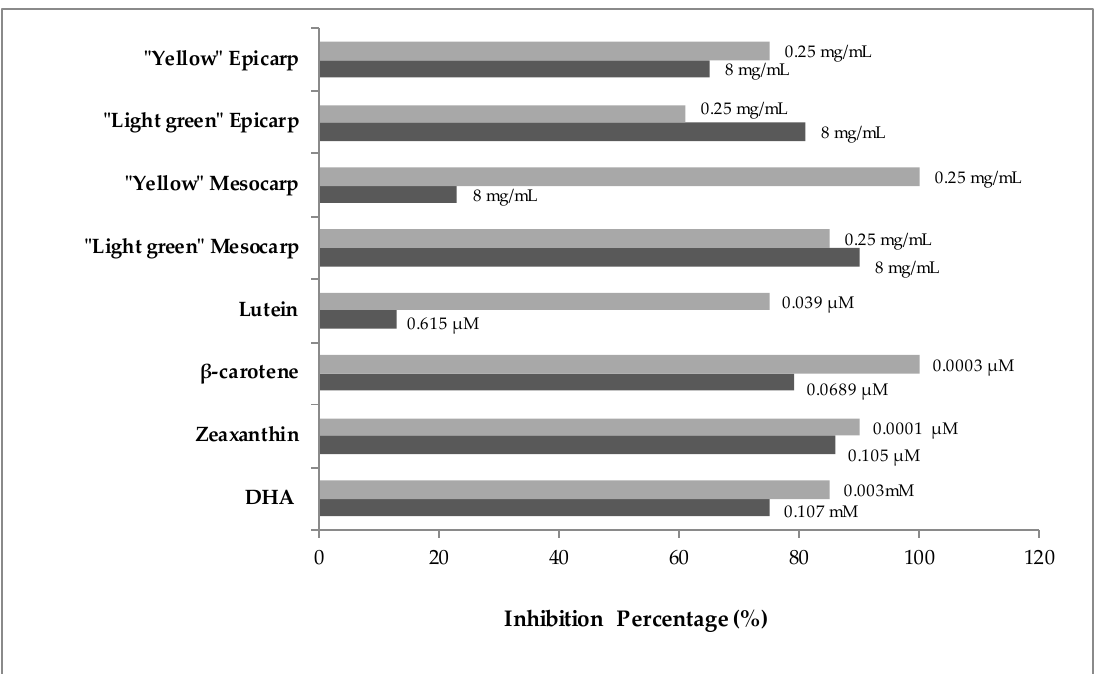
Figure 2. Inhibition percentages (IP) of zucchini epicarp and mesocarp and its bioactive compounds against H 2 O 2 -induced damage in the Drosophila wing spot test.